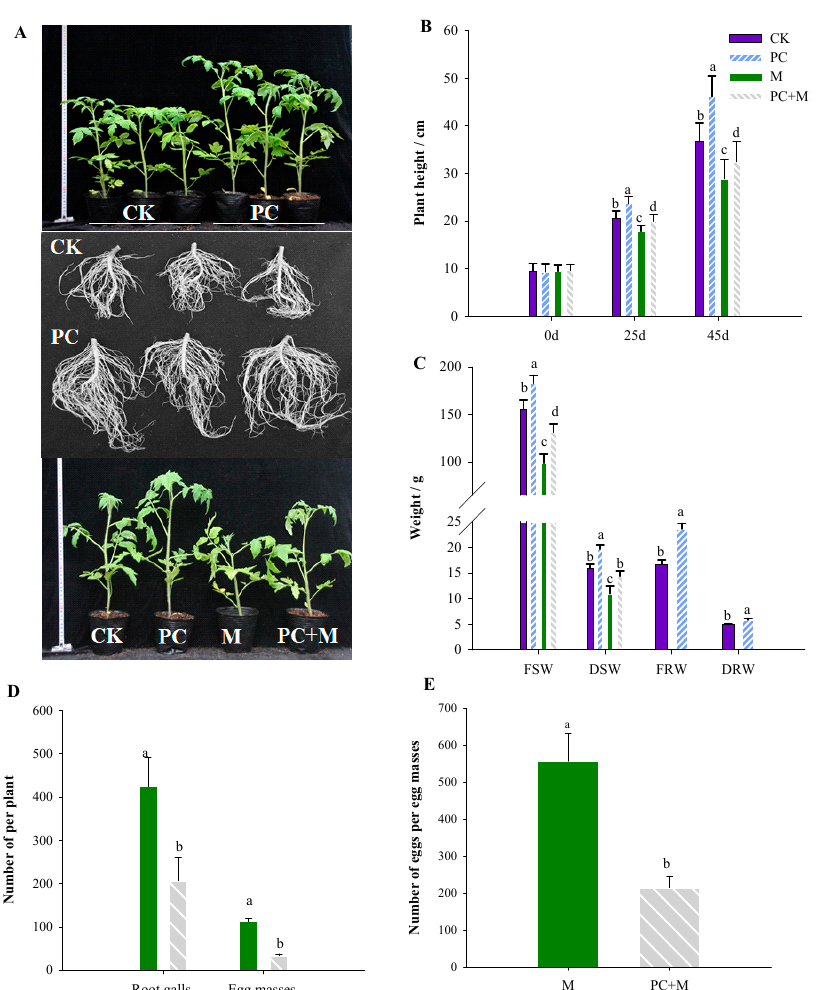
Figure 2. Pochonia chlamydosporia stimulates growth of tomato seedlings and reduces Meloidogyne incognita infection. CK: without any treatment; PC: inoculation with PC-170 strain; M: inoculation with M. incognita J2s; PC+M: inoculate first with PC-170, and then with M. incognita J2s. ( A ) Root growth 20 d after inoculation with PC-170. ( B ) Plant height at 0 d, 25 d, and 45 d under different treatments. ( C ) FSW (fresh shoot weight), DSW (dry shoot weight), FRW (fresh root weight), and DRW (dry root weight). ( D ) The number of root galls and the number of egg masses. ( E ) The number of eggs per egg mass. Each value is the mean ± SE ( n = 30). Different letters indicate statistical differences between treatments ( p < 0.05).